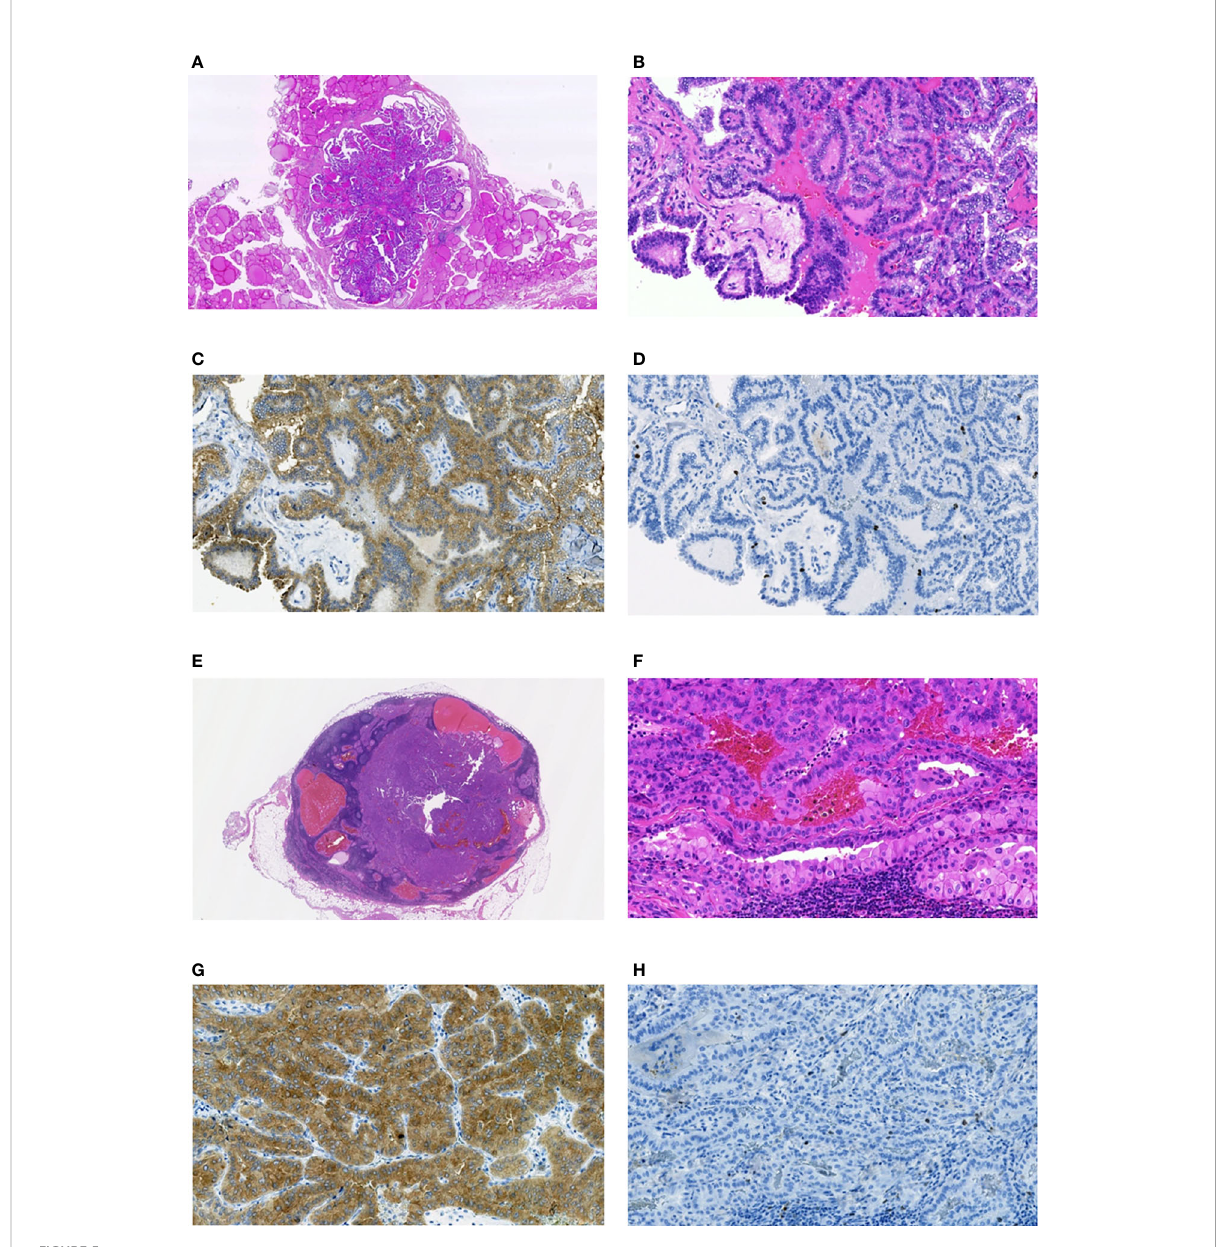
FIGURE 5 Radiogenic MPTC from male patient aged 11.6 years at the time of the Chornobyl accident and 42 years at the time of the fi rst surgery (estimated (POC=11%), and a RAI-R recurrent metastasis removed 1.6 years after the primary treatment. (A) non-encapsulated primary tumor sized 6 mm with the dominant papillary growth pattern, without extrathyroidal extension (pT1aN0M0 according to the 8 th Edition of TNM classi fi cation), hematoxylin-eosin, 14.5X magni fi cation. (B) fragment of the primary tumor with papillary structure, hematoxylin-eosin, 200X magni fi cation. (C) primary tumor: positive IHC reaction with anti-BRAF (mutated V600E) antibody, 200X magni fi cation. (D) primary tumor: IHC reaction with Ki67 (Clone MIB-1) antibody (Ki67 LI 2.8%), 200X magni fi cation. (E) RAI-R recurrent metastasis sized 10 mm with some cystic changes; hematoxylin-eosin, 12.0X magni fi cation. (F) fragment of the RAI-R recurrent metastasis: solid-trabecular structure, oncocytic cells, hematoxylin-eosin, 200X magni fi cation. (G) fragment of the RAI-R recurrent metastasis: positive IHC reaction with anti-BRAF (mutated V600E) antibody, 200X magni fi cation. (H) fragment of the RAI-R recurrent metastasis: IHC reaction with Ki67 (Clone MIB-1) antibody (Ki67 LI 2.0%), 200X magni fi